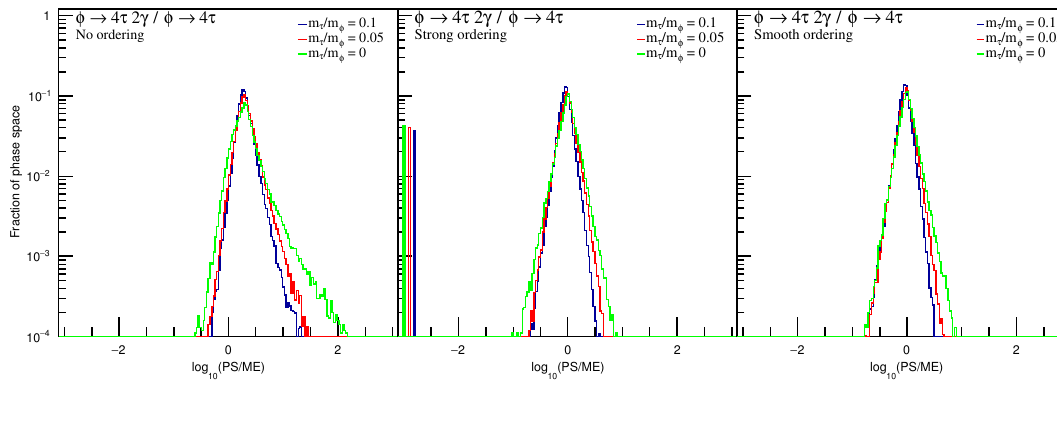
Figure 5 . Comparison of the shower approximation to matrix elements for (cid:30) ! 4 (cid:28) 2 (cid:13) matched to (cid:30) ! 4 (cid:28) for di(cid:11)erent types of ordering. The bars on the left side of the strong ordering comparison correspond with events that lie in the dead zone of the